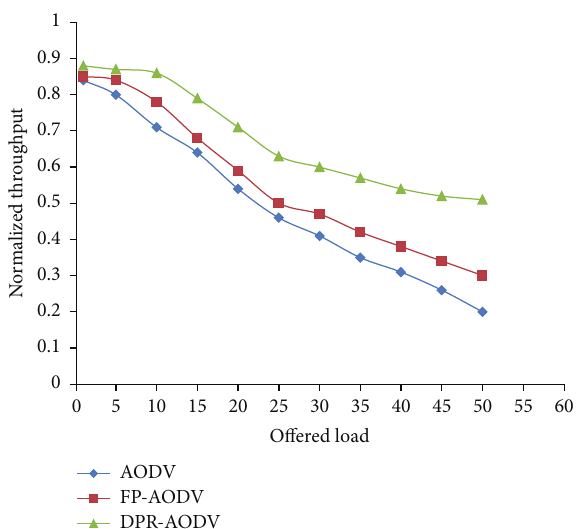
Figure 13: Delay versus offered